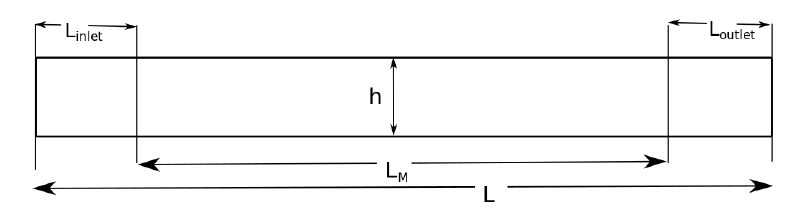
Figure 3. Schematic of a flat channel with the characteristic lengths.